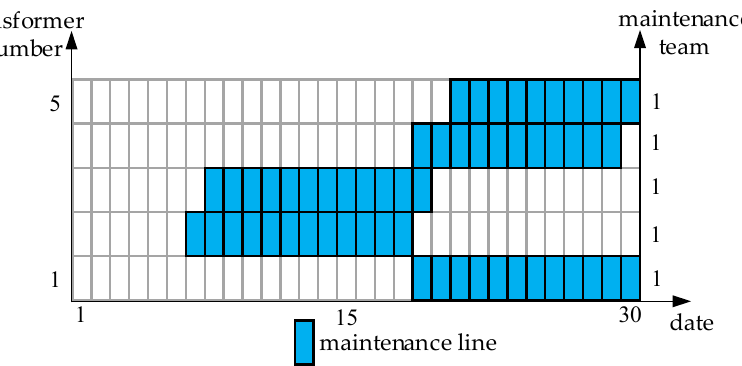
Figure 4. Transformer maintenance scheduling and resource arrangement.